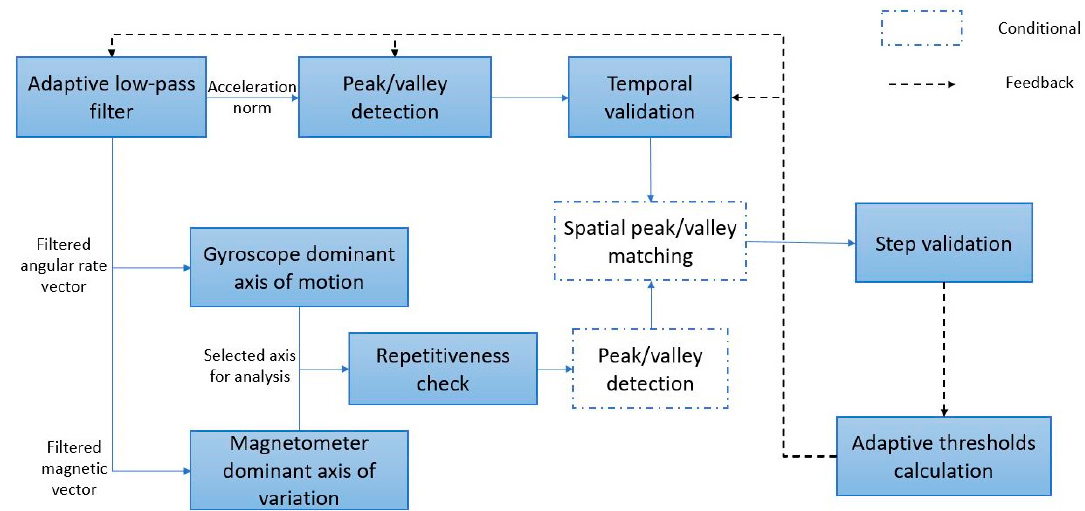
Figure 5. Step detection block diagram.